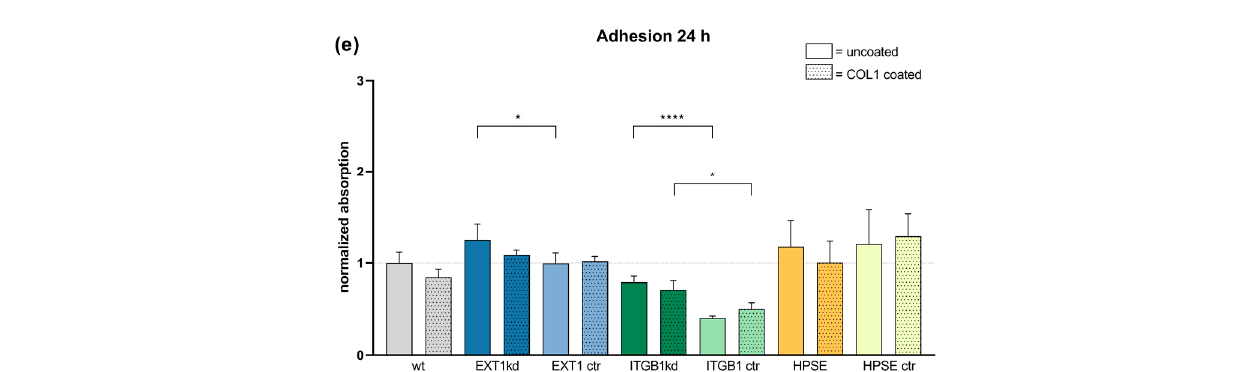
Figure 1. Comparison of cell proliferation rate ( a , b ) and cell adhesion capability ( c – e ) of MV3 wild- type cells and different transfected MV3 cells versus unspecific control on uncoated or COL1-coated surfaces depending on time. Cell proliferation of the indicated cells was detected by MTT assays over 96 h (( a , b ) and Figure S2) and compared to the proliferation of MV3 wt cells, taken as a rate of 1. ( c – e ) Cell adhesion was detected colorimetrically by labeling the cells after thorough washing and fixing at the surfaces. Data indicate that initially a superior binding onto COL1 surfaces after 0.5 h